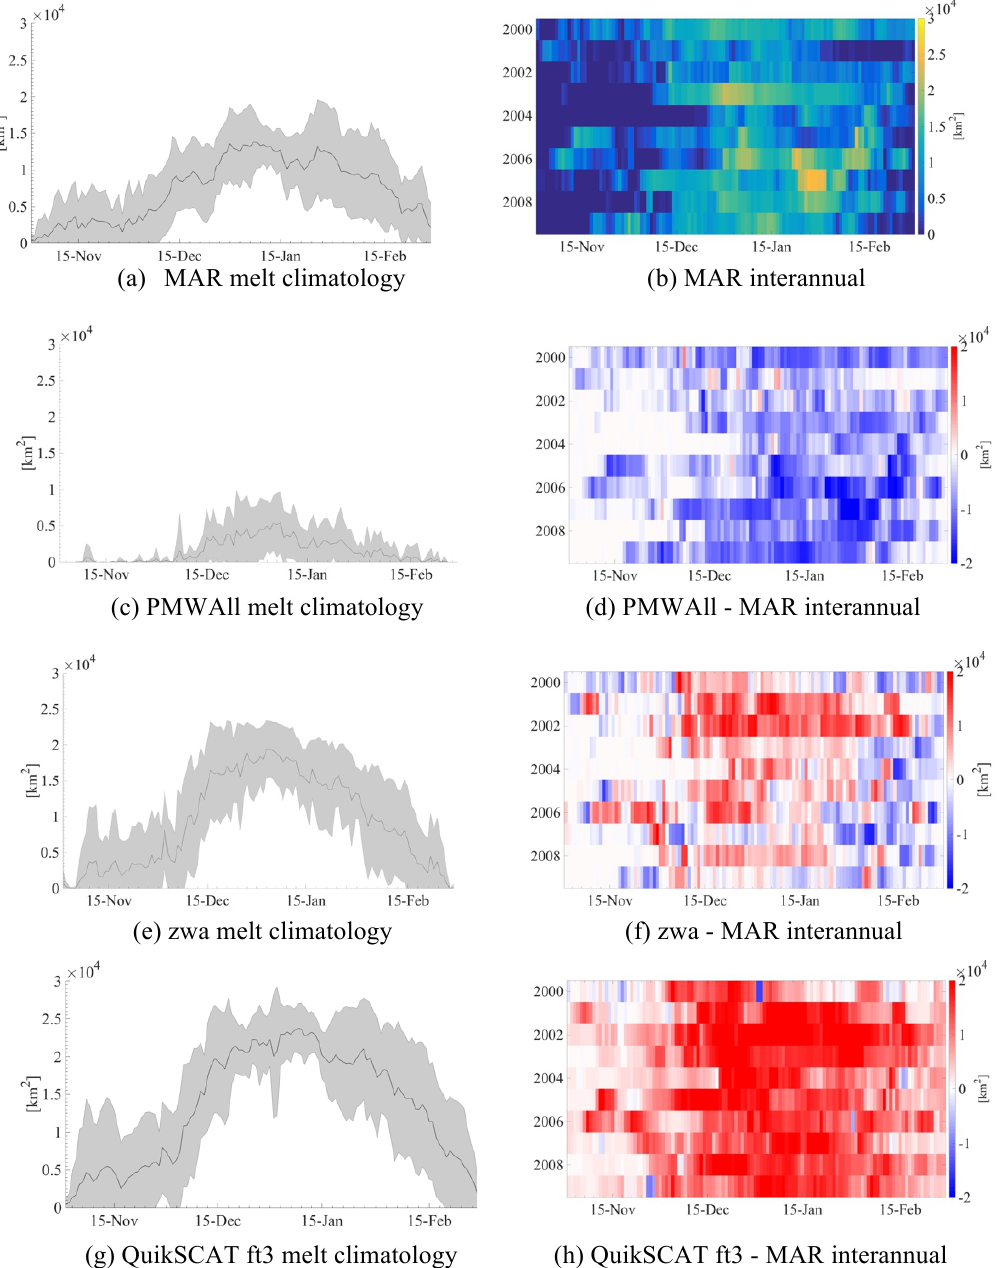
Figure 7. NL-region, described in text and shown inset in (c) , average and inter-annual melt occurrence in MAR, PMW, and QuikSCAT data. (a) MF 0 . 4 melt extent climatology with one standard deviation shown in grey envelope. (b) Melt extent for MF 0 . 4 from 1999–2009. (c) Melt climatology PMW All. (d) Interannual difference melt extent PMWAll – MAR. (e) Melt climatology PMW zwa. (f) Interannual difference in melt extent PMWzwal – MAR. (g) Melt climatology QuikSCAT ft3. (h) Interannual difference in melt extent QuikSCAT ft3 – MAR.